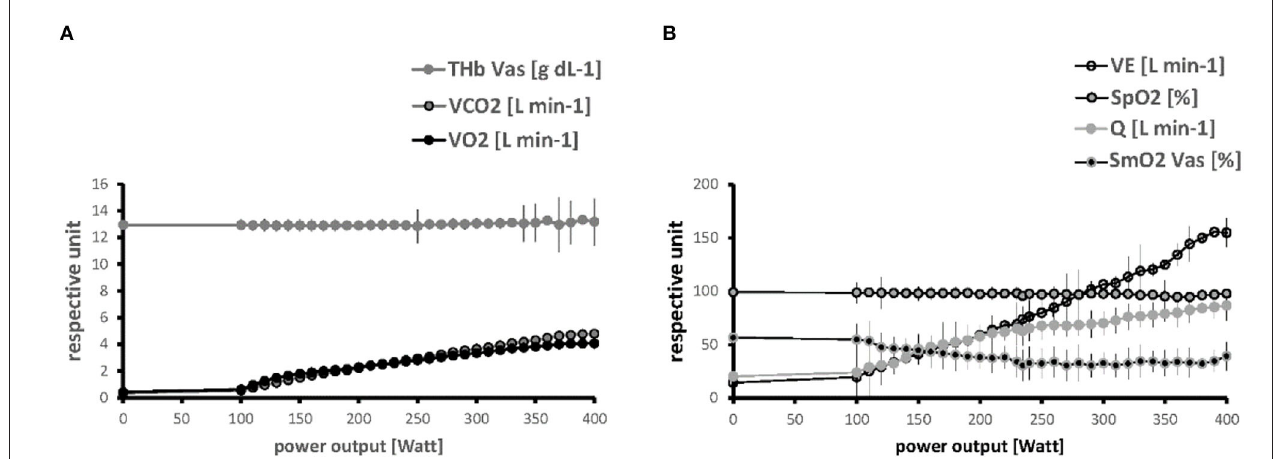
FIGURE 3 | Linearity of relationships between metabolic parameters and power output. Line graphs visualizing the progression of values for parameters of the pathway of oxygen respective to PO during the work phase of the ramp test, for THb, VCO 2 and VO 2 (A) and VE, SmO 2 , SpO 2 and Q (B) . Values are shown up to a maxima of 400 Watts when most subjects ceased pedaling. Symbols and vertical lines indicate mean + SD of values at an imposed PO in the studied 19 male subjects.